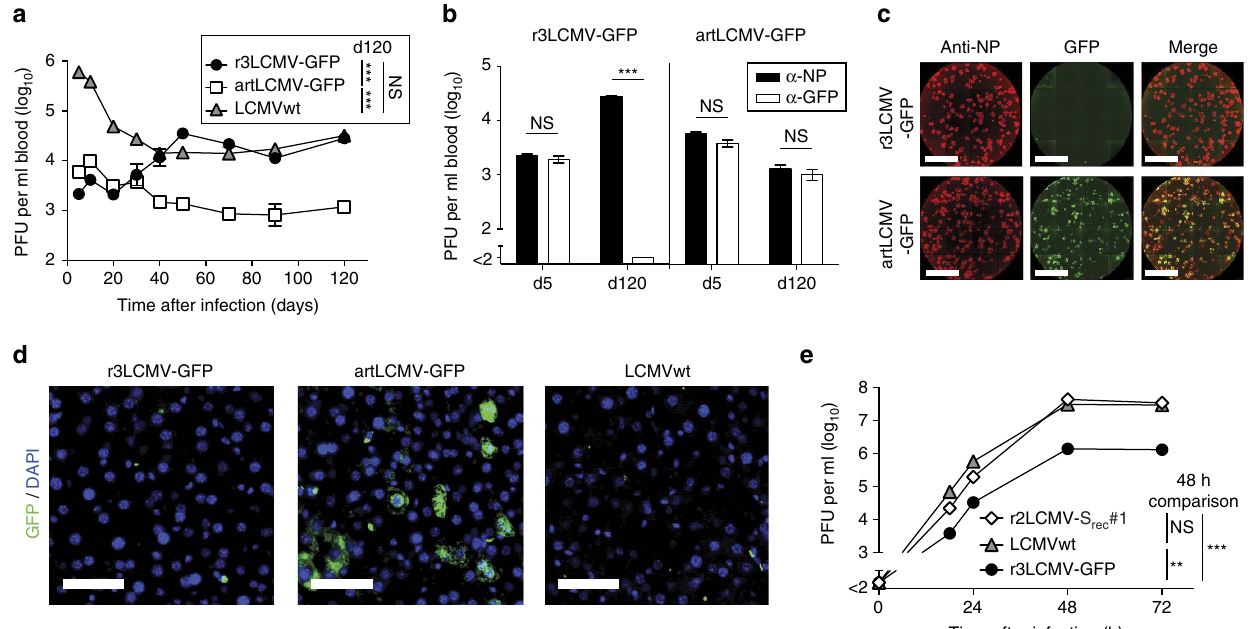
Figure 2 | Stable transgene expression and attenuation of artLCMV in vivo. ( a – d ) Viremia of AGRAG mice infected with r3LCMV-GFP ( n ¼ 7), artLCMV-GFP ( n ¼ 7) or LCMVwt ( n ¼ 3, a , d ). Symbols show the mean ± s.e.m. N ¼ 2. Blood samples obtained on d5 and d120 were processed for NP-IFF and GFP-IFF ( b ). Bars represent the mean ± s.e.m. of seven mice. N ¼ 2. Representative NP-IFF and GFP-IFF analyses of d150 serum ( c , scale bar, 0.5cm). Representative liver sections analysed for GFP þ cells on d150 ( d , scale bar, 50 m m). ( e ) Growth kinetics of LCMVwt, r3LCMV-GFP and r2LCMV-S rec #1 on BHK-21 cells (compare Supplementary Fig. 2e). Symbols represent the mean of three replicates (s.e.m. error bars hidden in the symbol size). N ¼ 2. Data in a (120 days after infection) and e (48h after infection) were analysed by one-way ANOVA with Bonferroni post hoc test. Data in b were analysed by unpaired two-tailed Student’s t -test. NS, not significant; ** P o 0.01 and *** P o